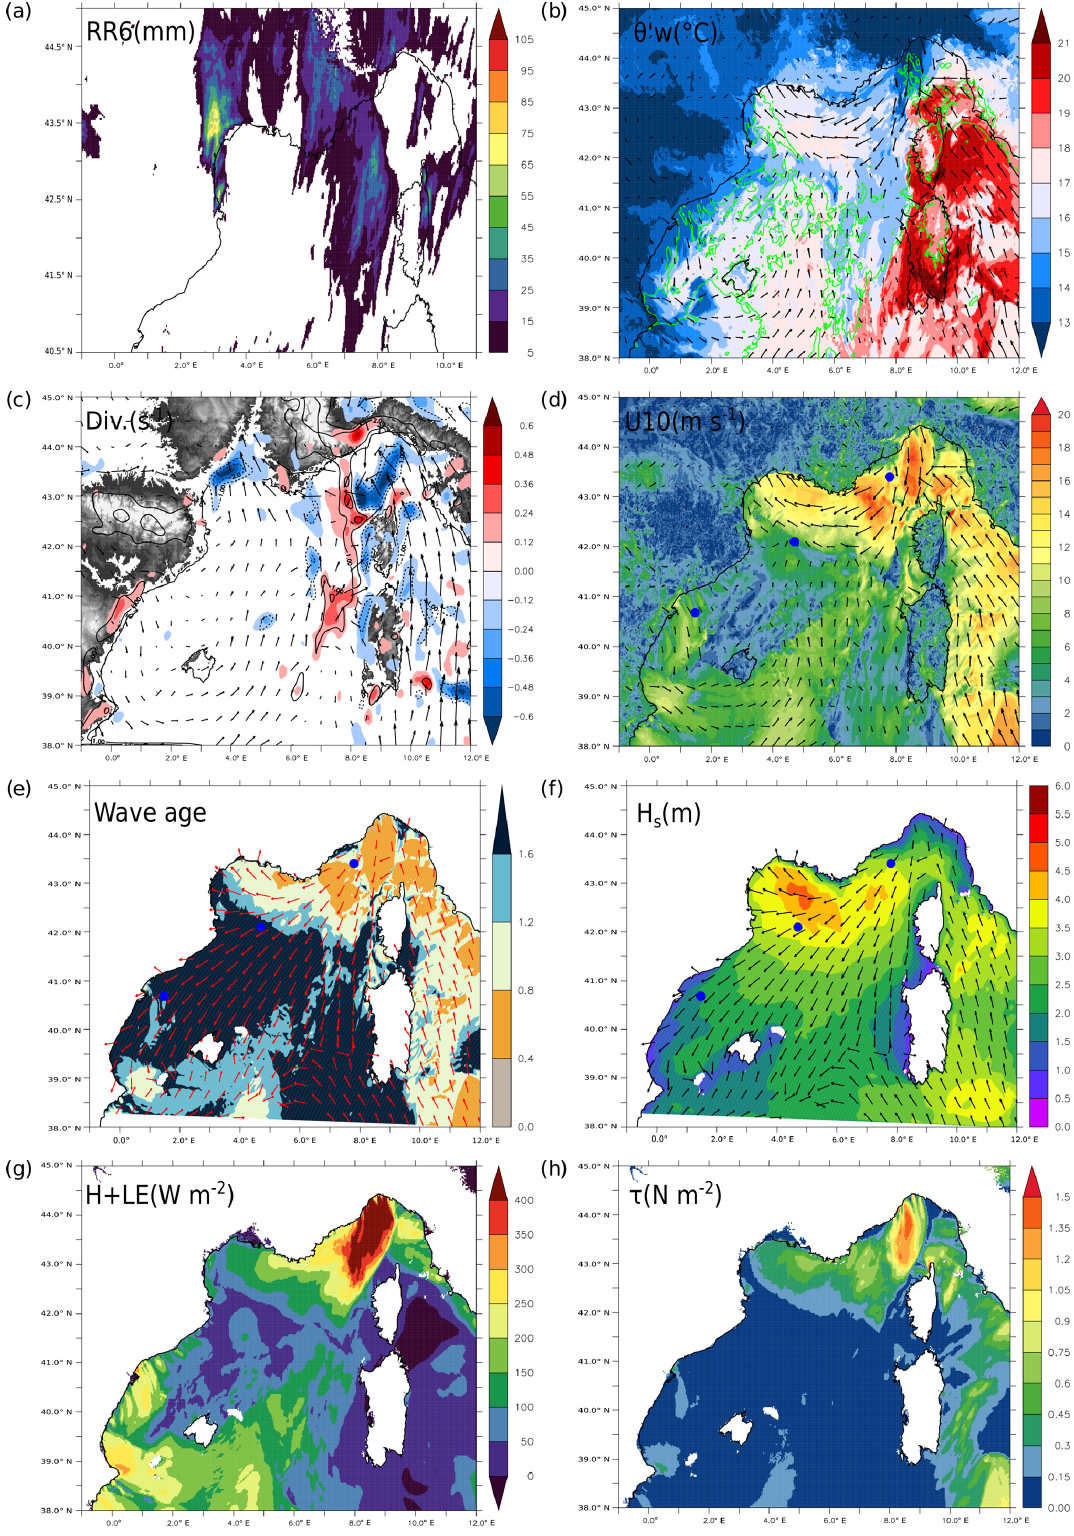
Figure 7. Same as for Fig. 5 but at 06:00UTC on 14